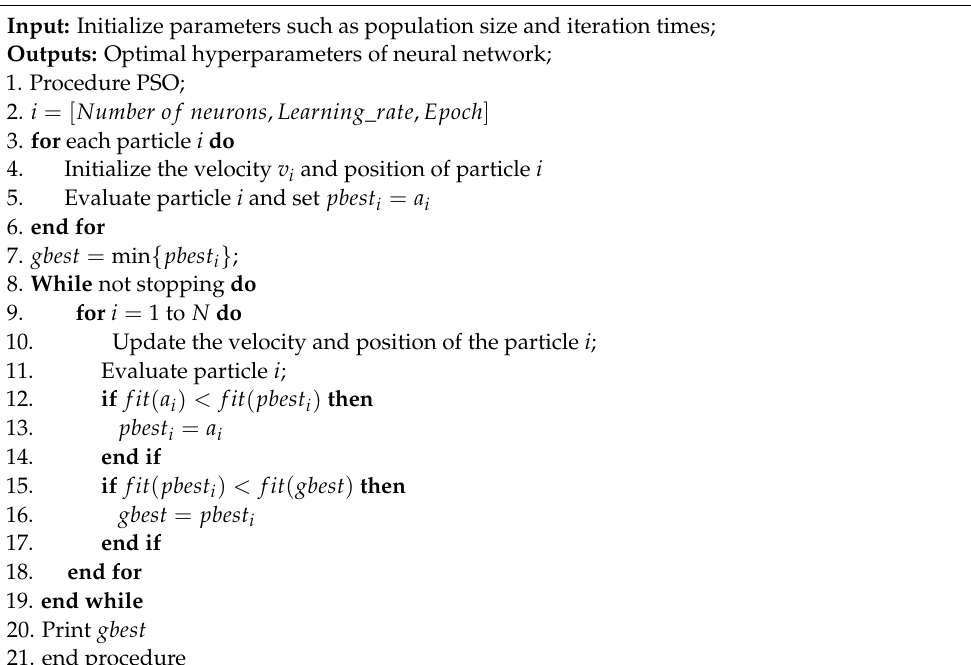
Algorithms 1: Optimization algorithm of model hyperparameters based on